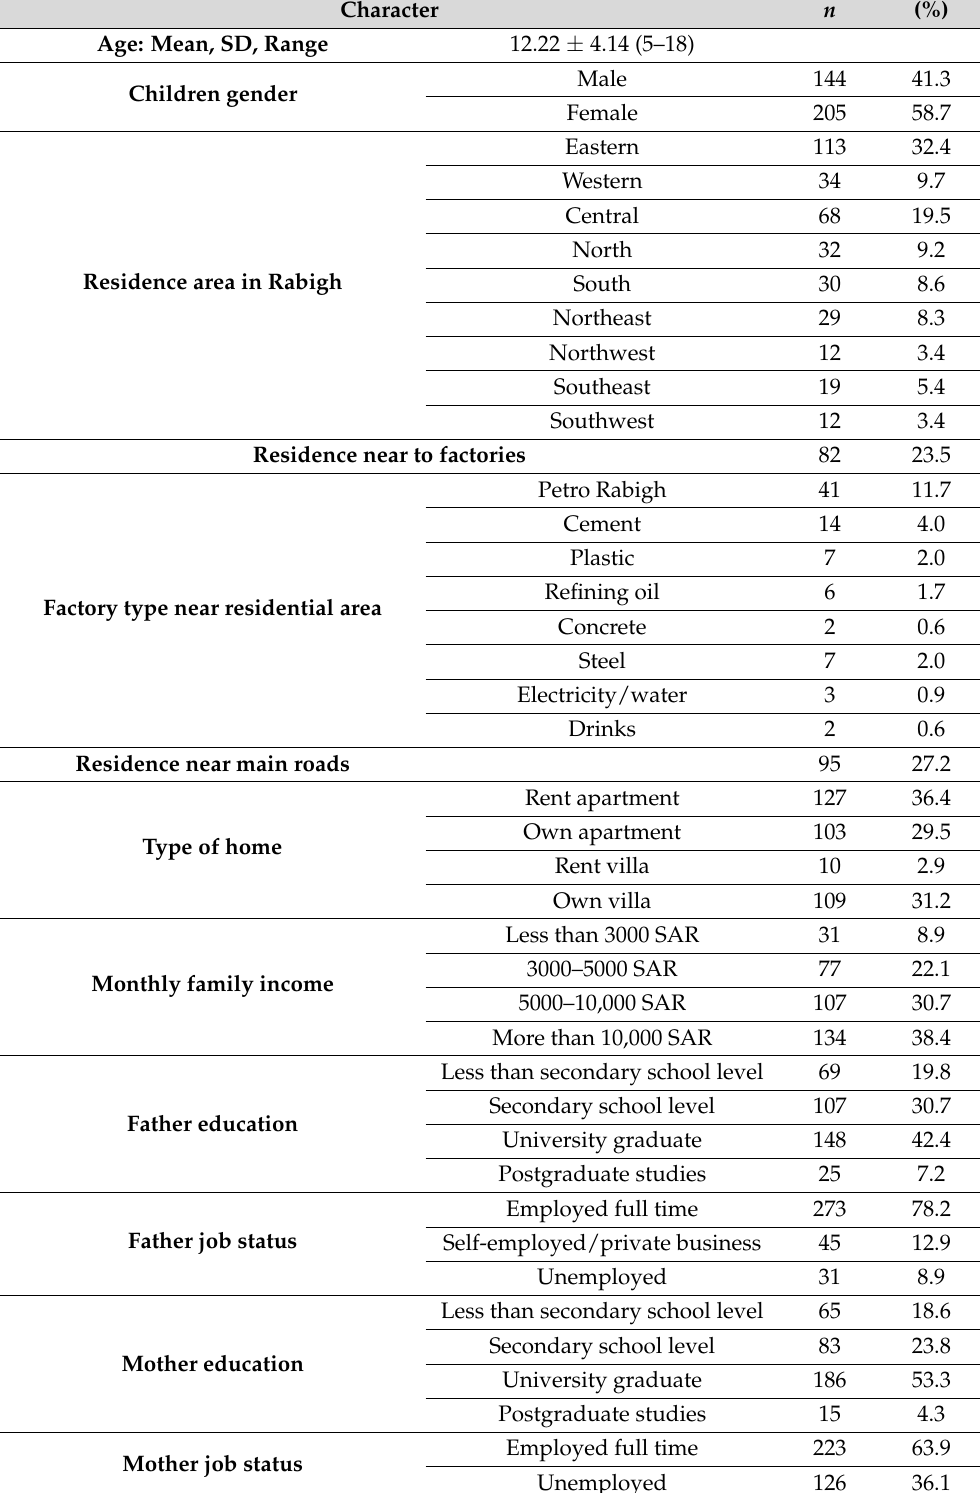
Table 1. Sociodemographic characteristics of participants ( n =